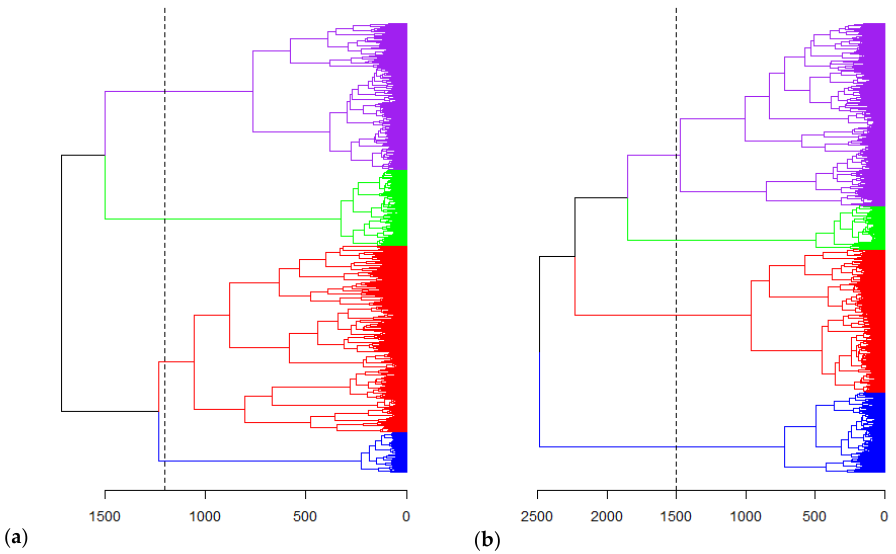
Figure 4. Hierarchical clustering of Sesbania sesban accessions by ( a ) SNP and ( b ) SilicoDArT mark ‐ ers.